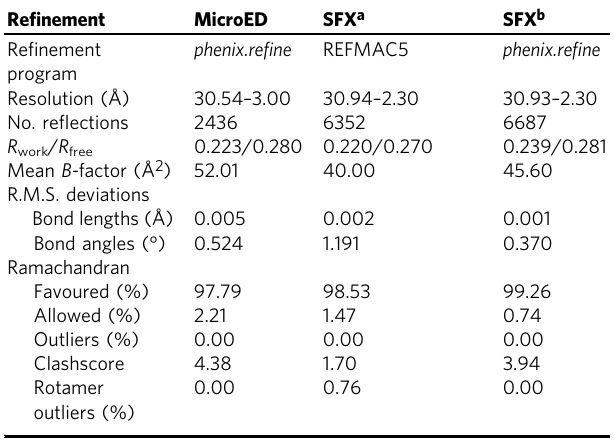
Table 2 Re fi nement